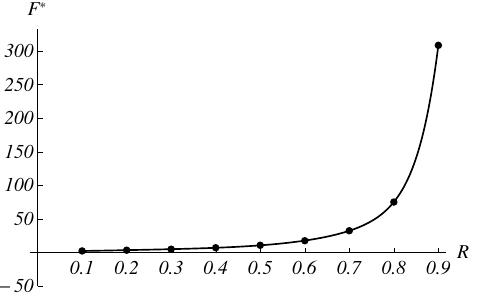
Figure 5. The dependence of F ∗ on R